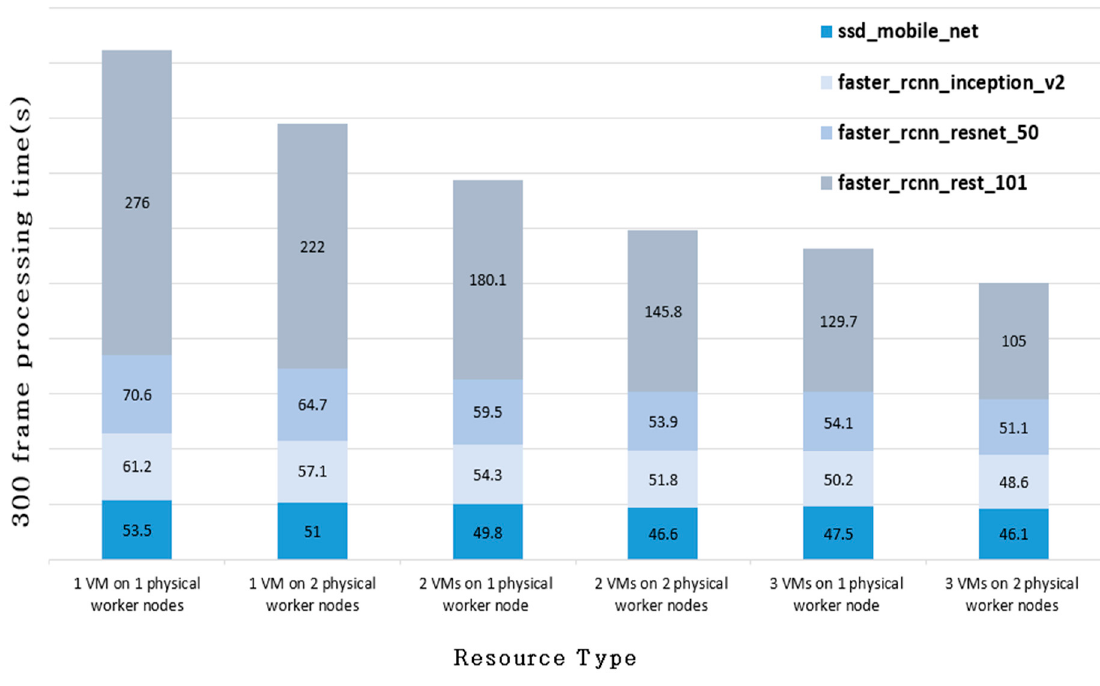
Figure 11. Model inference processing time according to the number of VM worker nodes.